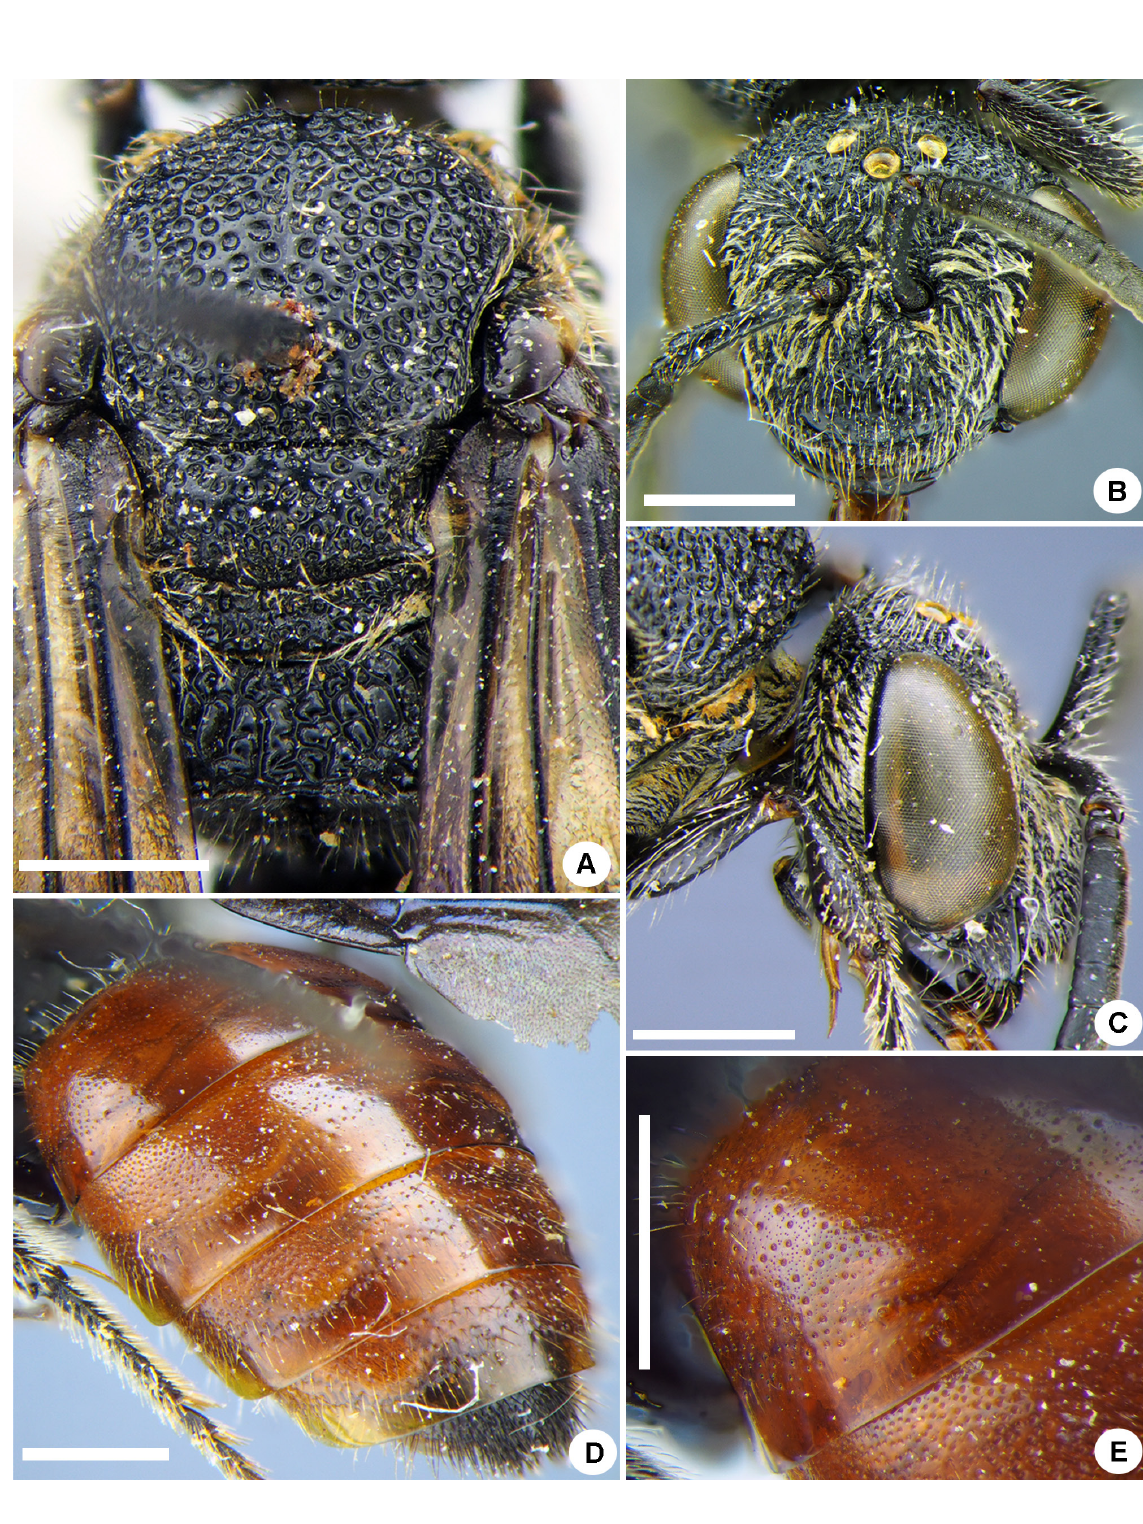
Fig. 22. Sphecodes uttaricus sp. nov. Holotype, ♀ (PCMS/OLBL). A . Mesosoma, dorsal view. B – C . Head in frontal (B) and lateral view (C). D . Metasoma in dorso-lateral view. E . T1 in dorso-lateral view. Scale bars = 1